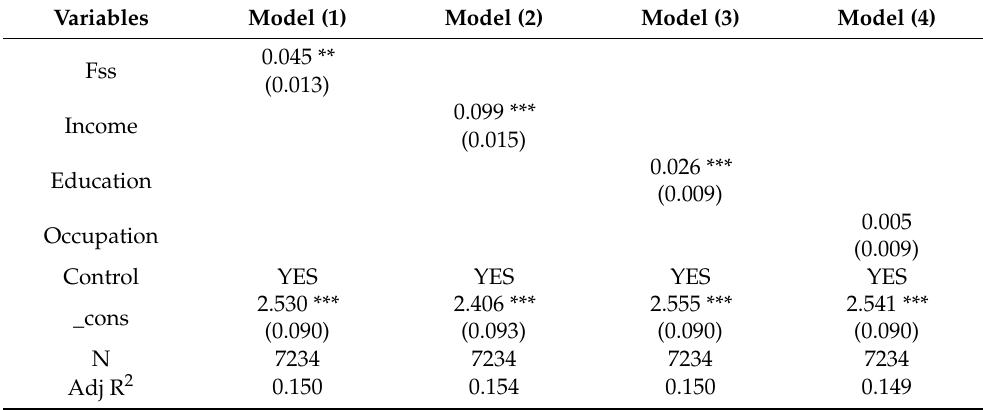
Table 5. Robustness test table for